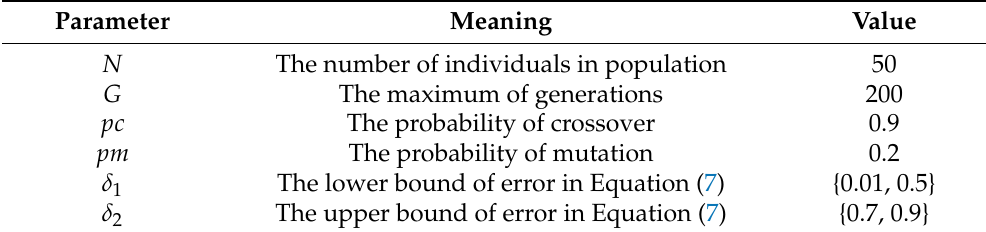
Table 2. Detailed parameters of the evolutionary multi-objective one-shot filter pruning. Parameter Meaning Value N The number of individuals in population 50 G The maximum of generations 200 pc The probability of crossover 0.9 pm The probability of mutation 0.2 δ 1 The lower bound of error in Equation (7) {0.01, 0.5} δ 2 The upper bound of error in Equation (7) {0.7,